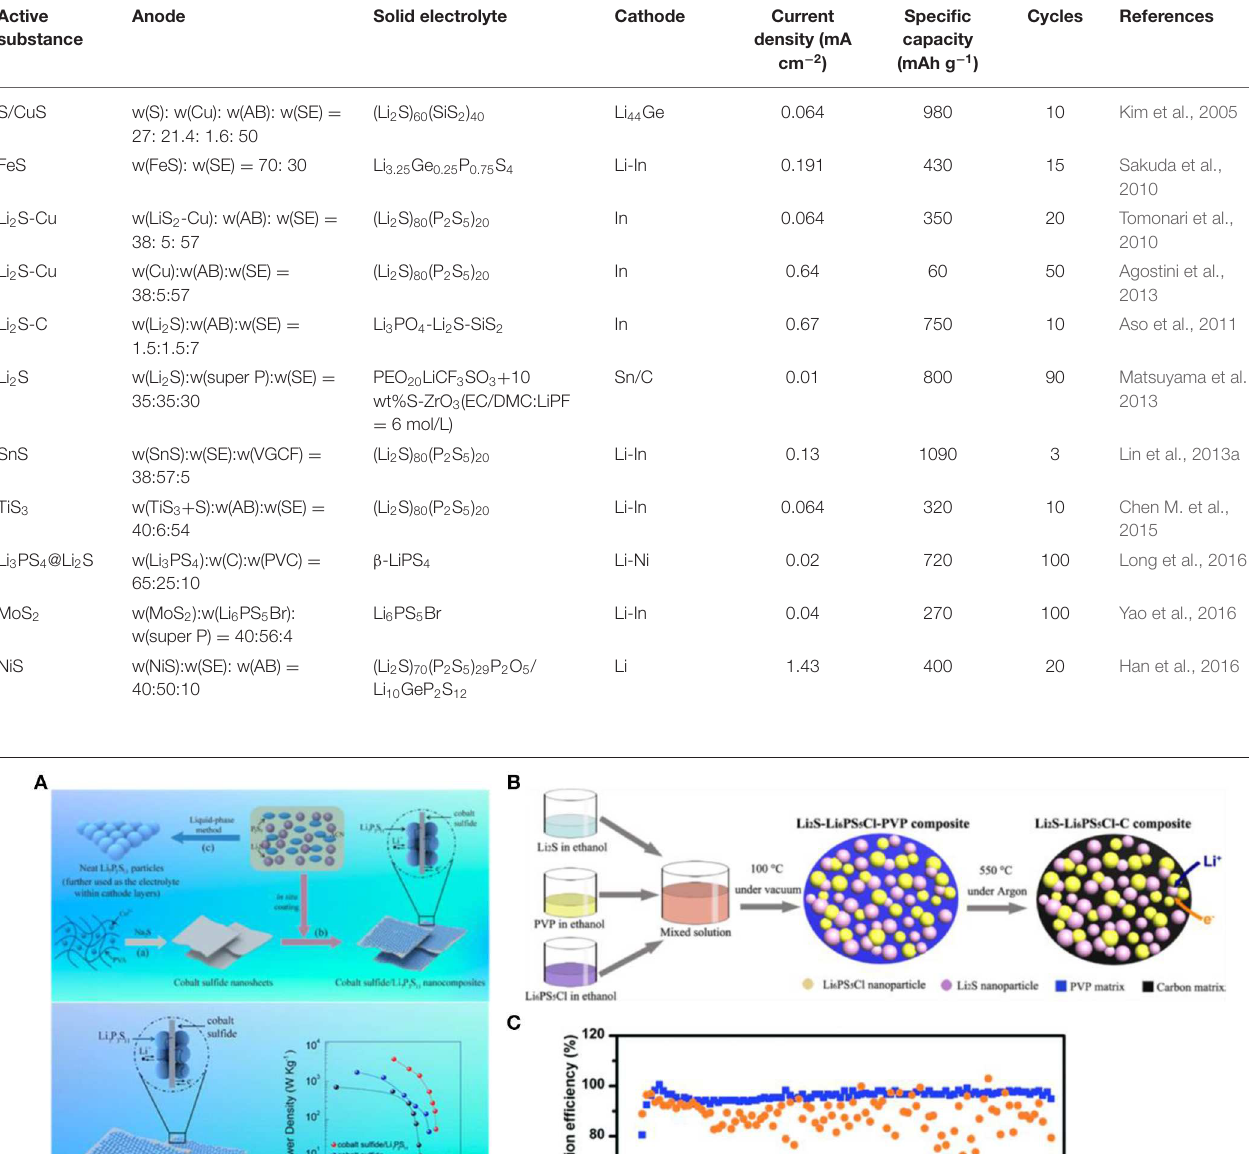
TABLE 2 | The electrochemical performance of inorganic sulfurized cathode in solid-state Li-sulfur battery. Active Anode Solid electrolyte Cathode Current substance